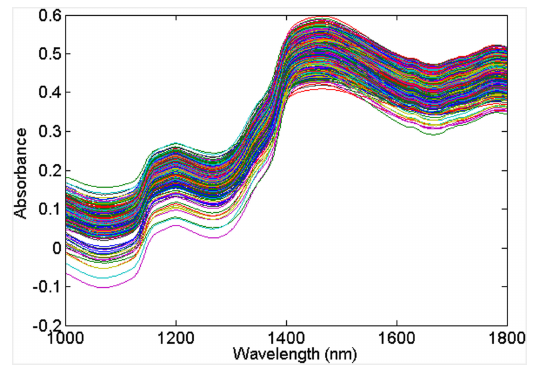
Fig. 2. Original NIR spectra of all Nanfeng mandorin